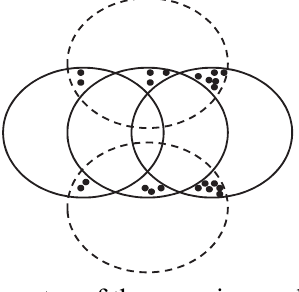
Fig. 1. Geometry of the covering problem sample